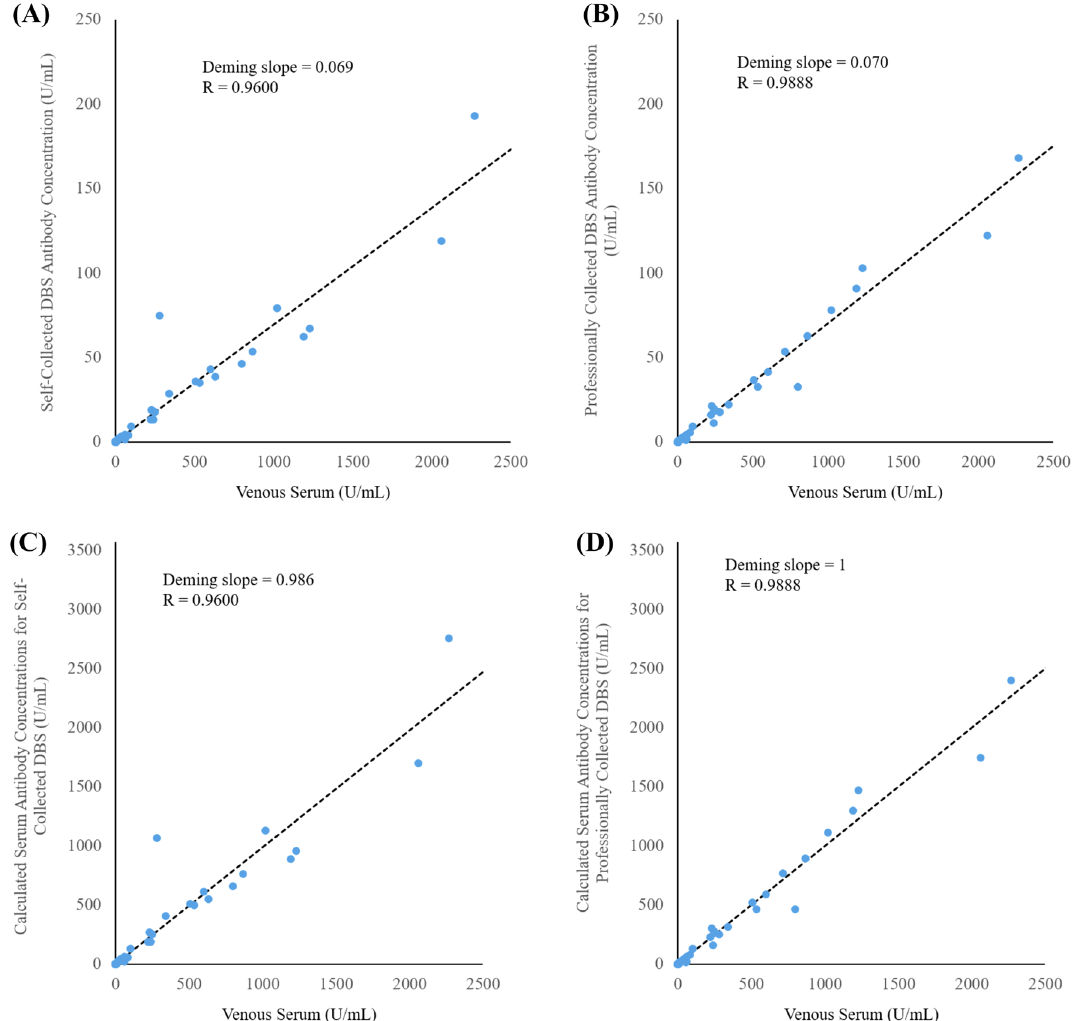
Figure 2. Serum antibody concentrations compared to ( A ) self-collected DBS sample antibody levels and ( B ) professionally collected DBS sample antibody levels. Calculated serum concentrations are also shown with respect to DBS concentrations (by dividing DBS results by 0.070) for both ( C ) self-collected and ( D ) professionally collected